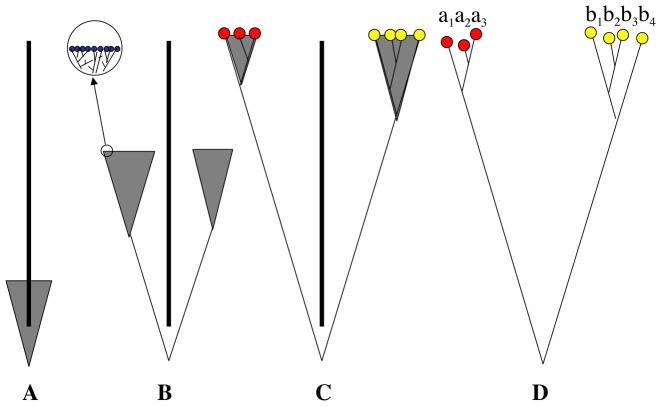
Models of successive times after speciation (A–C) with sampling at stage C (D).The bases of the inverted shaded isosceles triangles in A–C represent populations with effective size Ne individuals, while the vertex represent the most recent common ancestor. The altitude of the triangles represents coalescent time = 2Ne generations. The vertical bar represents a barrier to gene flow that splits the population in two. The inset in B shows some of the genes (black circles) and their relationships. Red and yellow circles in C and D are samples of genes. Nucleotide diversities π of the two species are estimated by the mean sequence differences aiaj and bibj; θ is a function of π and the sample sizes. K is the mean of the sequence differences aibi, corrected for multiple hits.